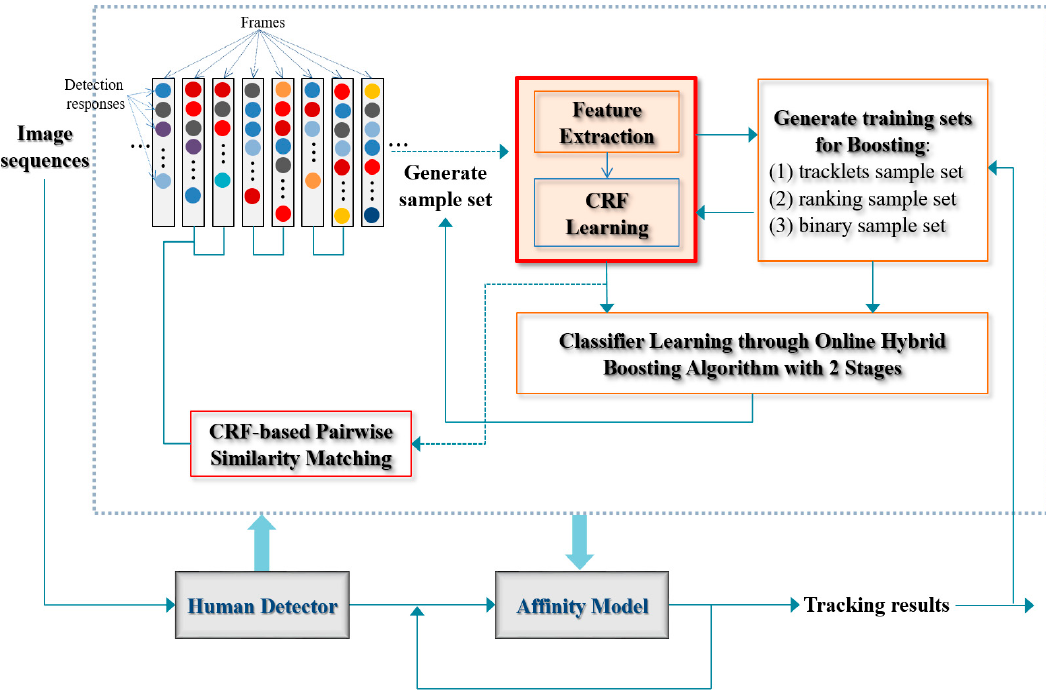
Figure 1. Schematics of the proposed MOT system.